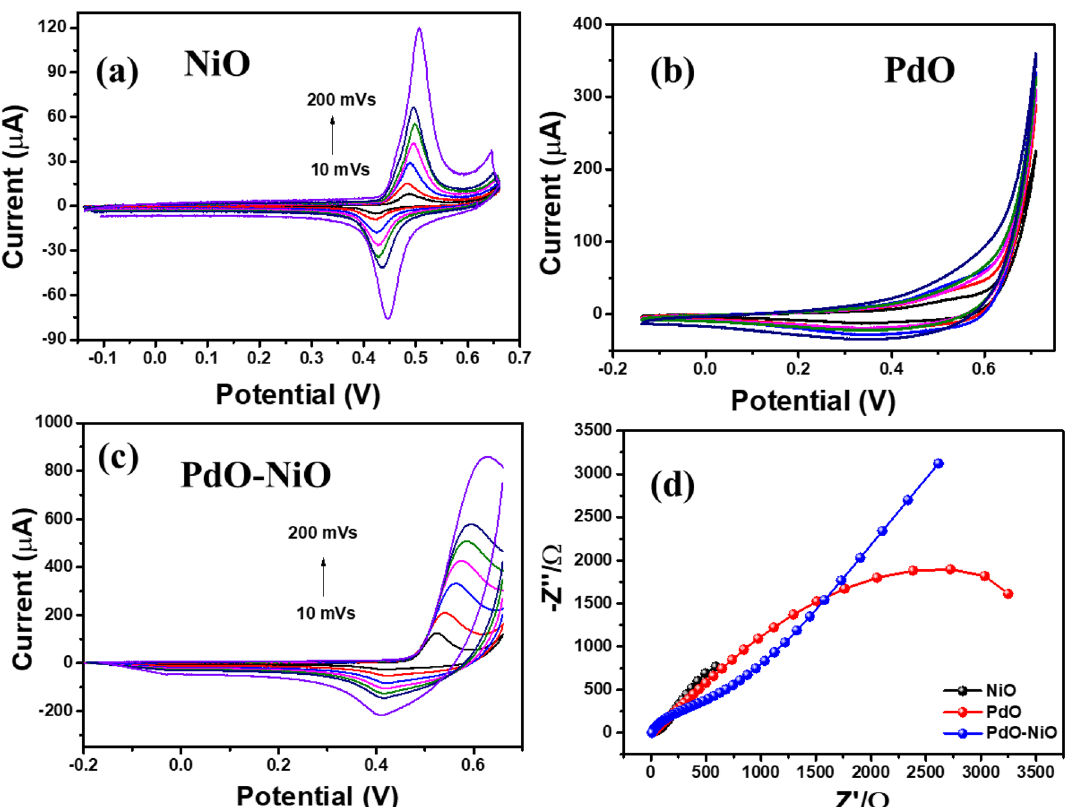
Figure 7. ( a – c ) Cyclic voltammetry and ( d ) EIS curves of NiO, PdO and PdO–NiO nanocomposite in 1 M KOH electrolyte